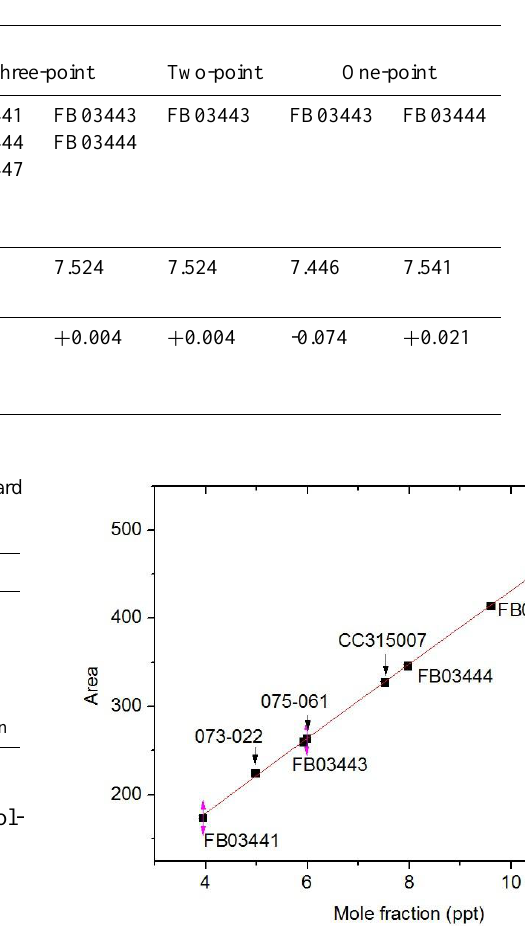
Table 3. Calculated result of SF 6 in the working standard CC315007 depending on the calibration methods that are referred to the WMO scale. Unit is ppt.